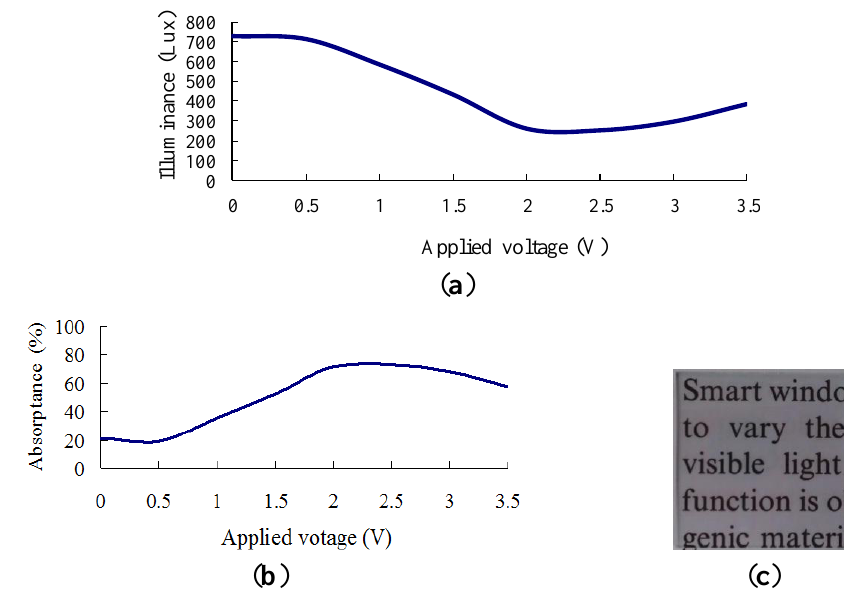
Figure 7. Transmittance and absorptance properties of ITO/WO electrolyte/ITO stack given electrolyte thickness of 250 nm and incident illuminance of 900 Lux. ( a ) Transmittance given applied voltage of 0–3.5 V; ( b ) absorptance given applied voltage of 0–3.5 V; and ( c ) transparency of EC stack given no applied voltage.